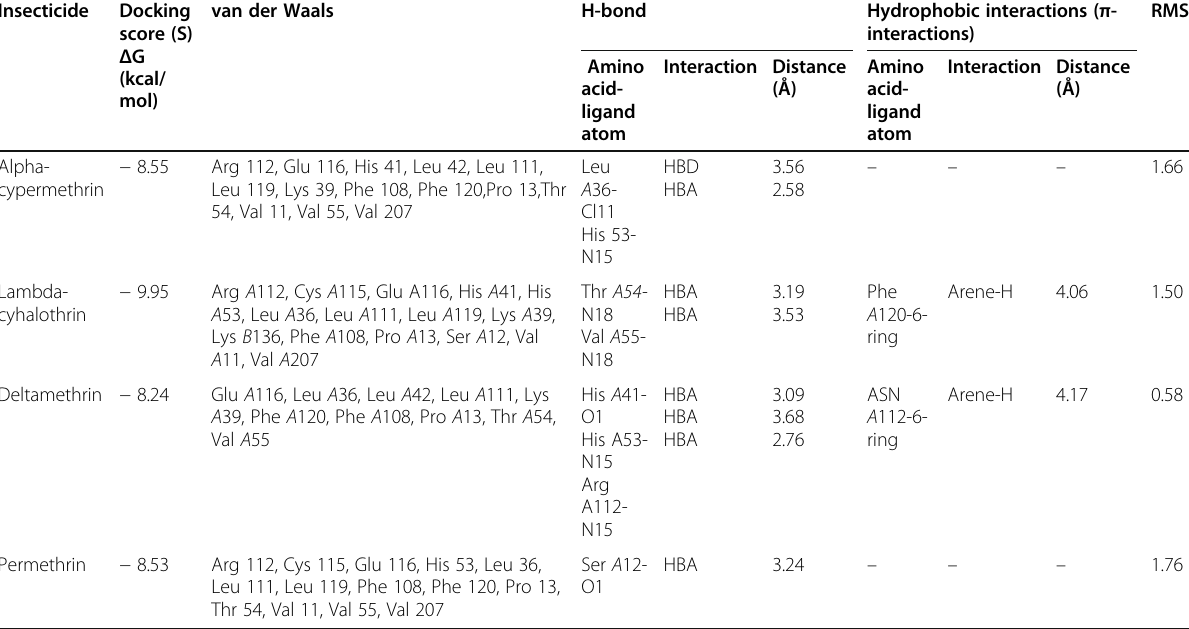
Table 6 Molecular docking, binding scores and binding interactions of tested pyrethroids within the active sites of GST (PDB ID: